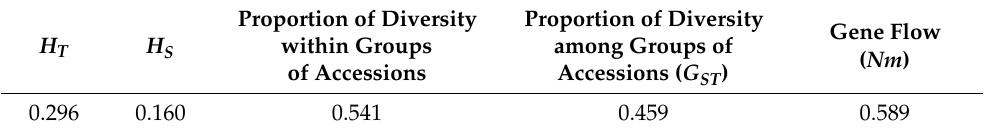
Table 6. Nei’s estimates of total genetic diversity, intra-specific genetic diversity, the proportion of diversity within and among the accessions, and the degree of gene flow in C. intybus . Proportion of Diversity Proportion of Diversity Gene Flow H T H S within Groups among Groups of of Accessions Accessions ( G ST ) 0.296